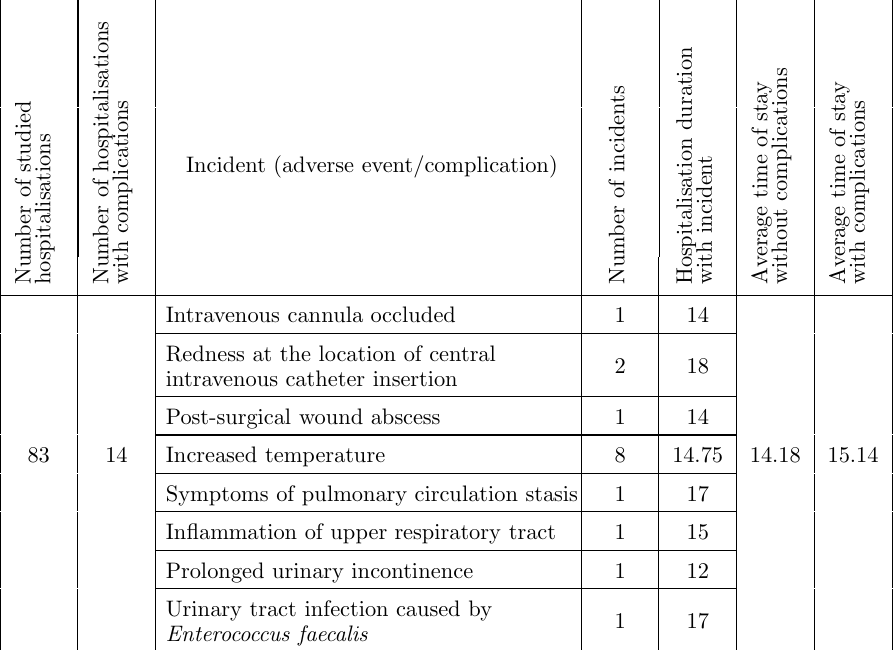
Symptoms of pulmonary circulation stasis Inflammation of upper respiratory